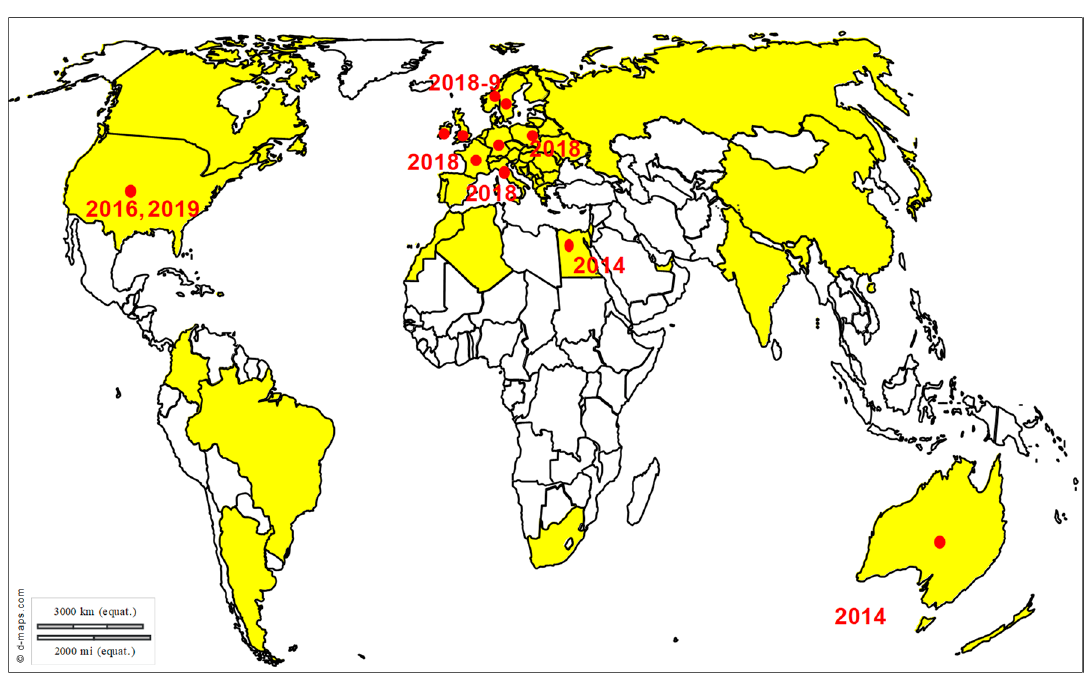
Figure 4. Distribution of EHV-1 outbreaks. Recent outbreaks in horses reported to the OIE WAHIS (World Animal Health Information System) interface [15], Promed Alerts (http://www.promedmail.org) [16] or in the scientific literature are depicted by dots (2014–2019).